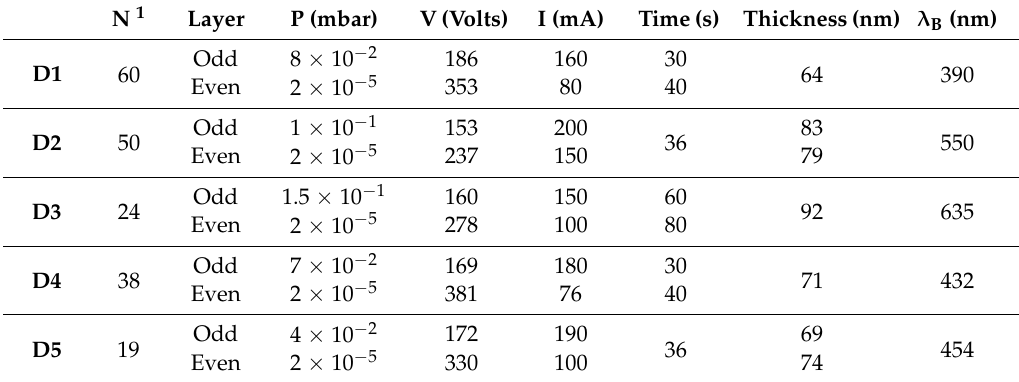
Table 1. Sputtering parameters for the fabrication of the optical fiber humidity sensors. N